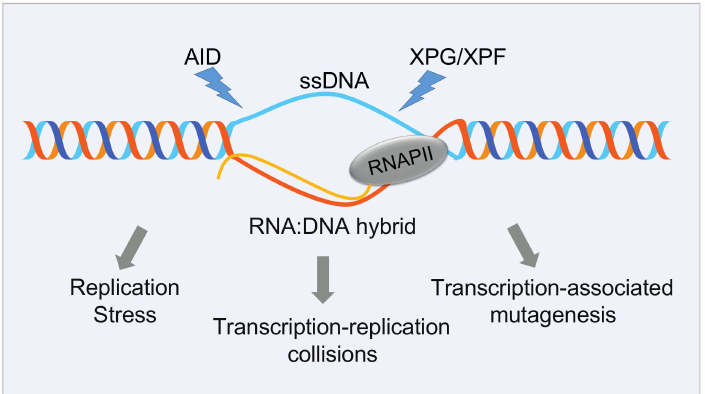
Figure 3. Detrimental consequences of unscheduled R-loop formation. Although R-loops are important for regulating diverse cellular events, they may have a negative impact on transcription elongation, DNA replication, and seriously compromise genome integrity, being a potential source of hypermutation, hyperrecombination, chromosomal rearrangements, or chromosome loss. The single- stranded DNA (ssDNA) that is exposed during R-loop formation is particularly vulnerable to DNA damage through the action of specific nucleases, such as activation-induced cytidine deaminase (AID), which promotes the conversion of dC to dU residues specifically on ssDNA, making the DNA susceptible to base excision repair enzymes, which in turn generate a DNA lesion, or XPF and XPG, two endonucleases involved in nucleotide excision repair. Alternatively, R loops may cause genome instability by stalling the progression of the replication fork. This may be the most relevant detrimental effect of R-loops in cycling S-G2